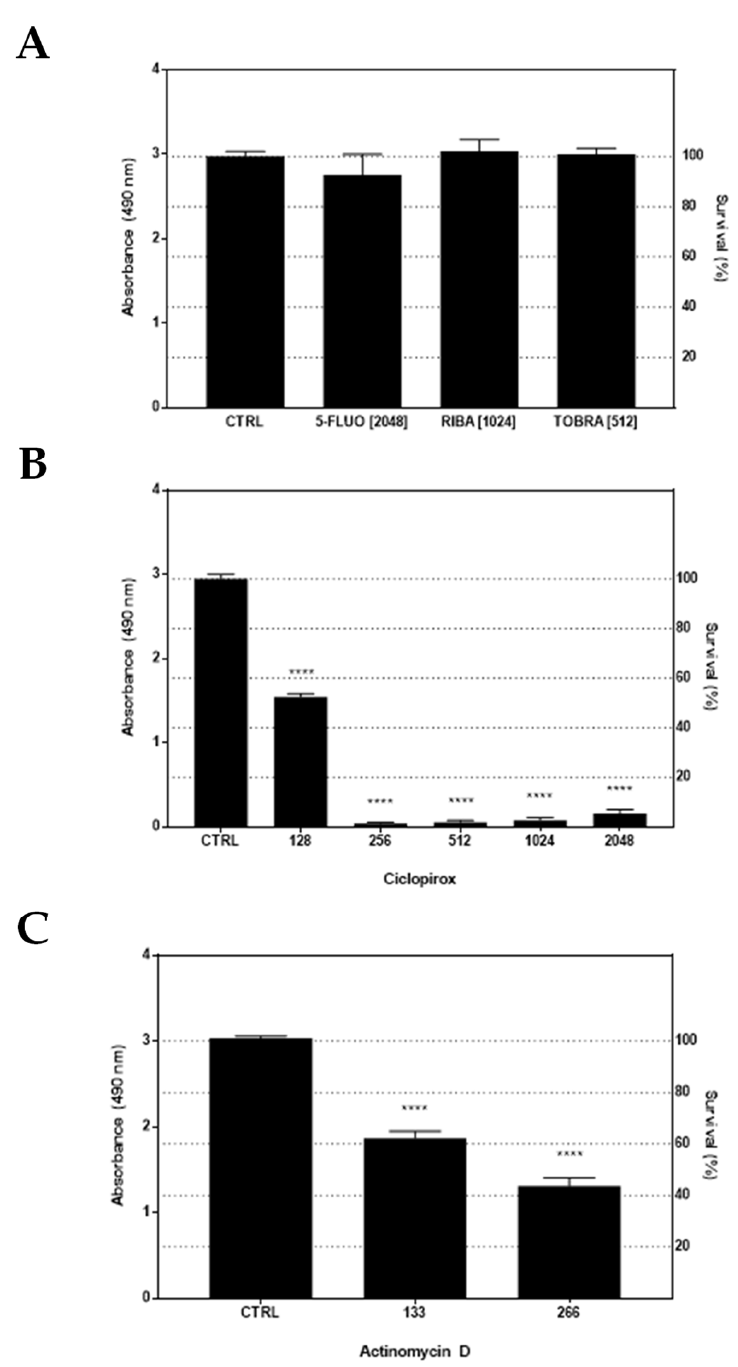
tested at the maximum concentration active against planktonic and/or biofilm P. aeruginosa cells (Figure 10).